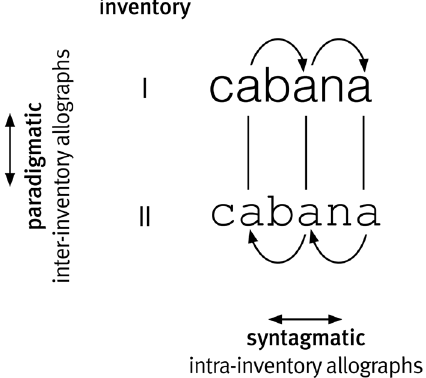
Figure 4: Intrainventory and interinventory graphetic